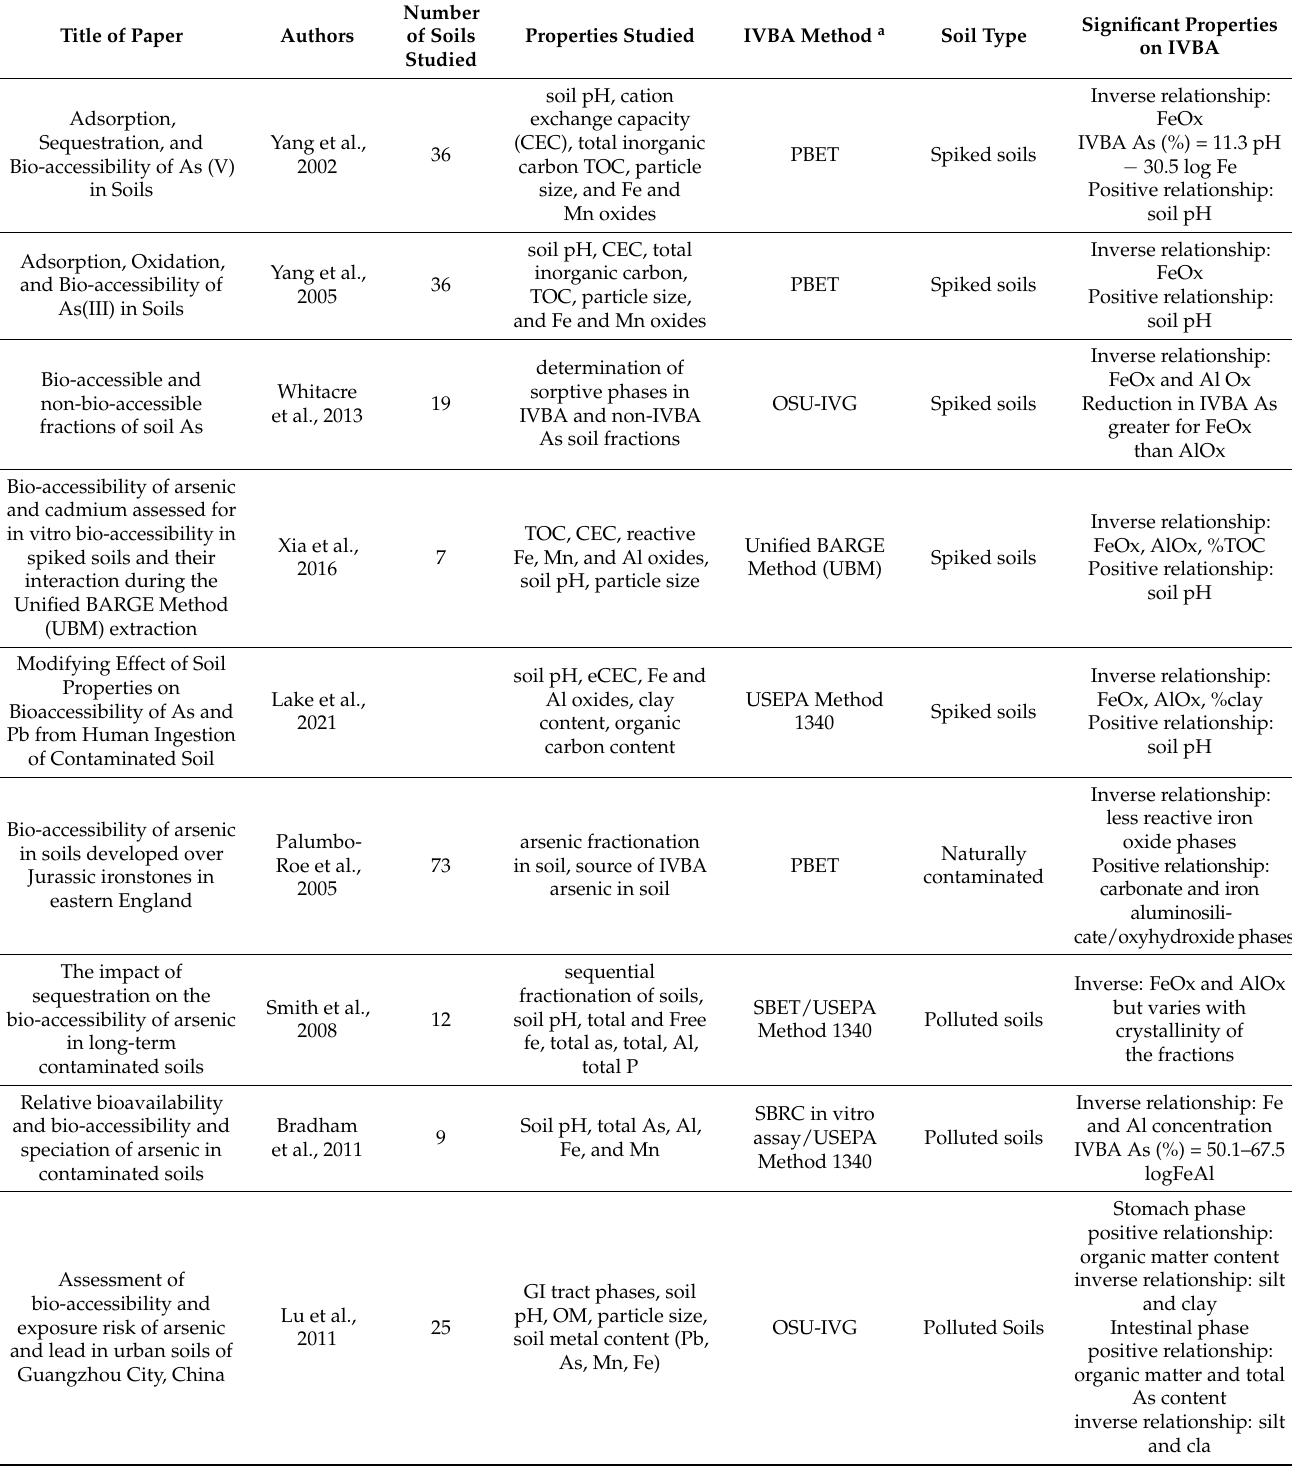
Table 1. Studies on the Effect of Soil Properties on Bio-accessible